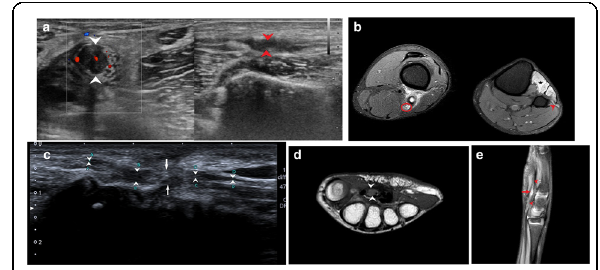
Fig. 11 a Transverse HRUS shows partial loss of fascicular architecture with nerve thickening in the CPN (white arrowheads in panel on the left) soon after its origin from the sciatic nerve in a patient with post-traumatic foot drop with concomitant osteomyelitis. Also note the increased vascularity in the nerve suggestive of neuritis. The CPN was discontinuous with formation of this ‘ end neuroma ’ . The panel on the right shows the distal segment of the discontinuous CPN which is hypoechoic and thickened (red arrowheads). b PDFS MR axial image shows pseudoneuroma with partially preserved fascicular architecture (encircled in red) with surrounding oedema, with distal segment showing hyperintensity (red arrowhead). There is hyperintensity in the peronei muscles (asterisk) suggestive of failure of regeneration. c Thickened hypoechoic median nerve (between arrowheads) with loss of continuity (arrow) in a case with penetrating injury to the forearm. d Axial T1-weighted image shows loss of fascicular architecture with hypointense neuroma formation (arrowheads) at the distal cut end of the proximal segment. e Sagittal PDFS image shows hyperintense median nerve (arrowheads) with focal loss of continuity which is seen as linear hyperintensity (red arrow) in the same patient